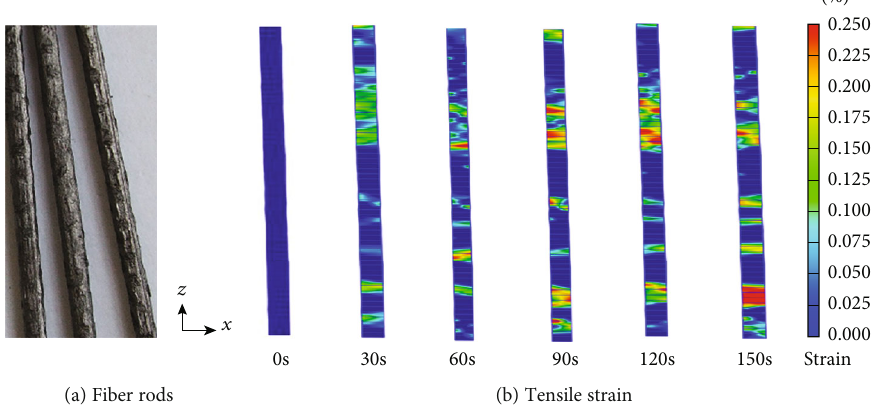
Figure 2: The strain test results of fi ber rod during tensile process.